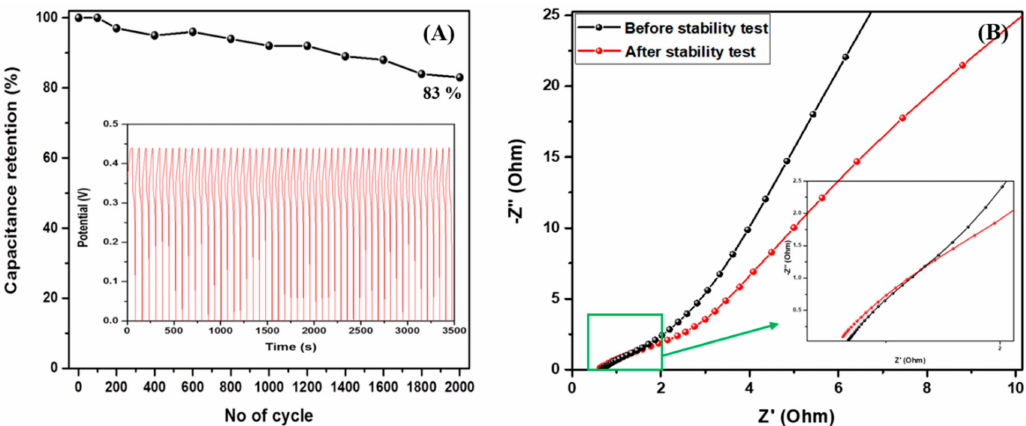
Figure 8. Cyclic stability for 2000 cycles ( A ) and EIS profile of the Fe 1 − x S-TiO 2 / CNFs composite electrode ( B ). Inset A represents GCD profiles for 50